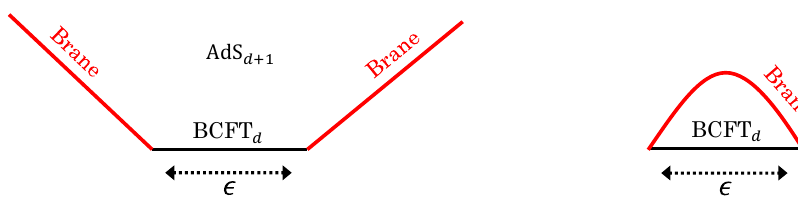
Figure 3 . BCFT with two boundaries. In the (cid:15) → 0 limit, the left setup leads to the duality between AdS gravity and CFT , so-called the wedge holography. On the other hand, the d +1 d − 1 right setup vanishes in this